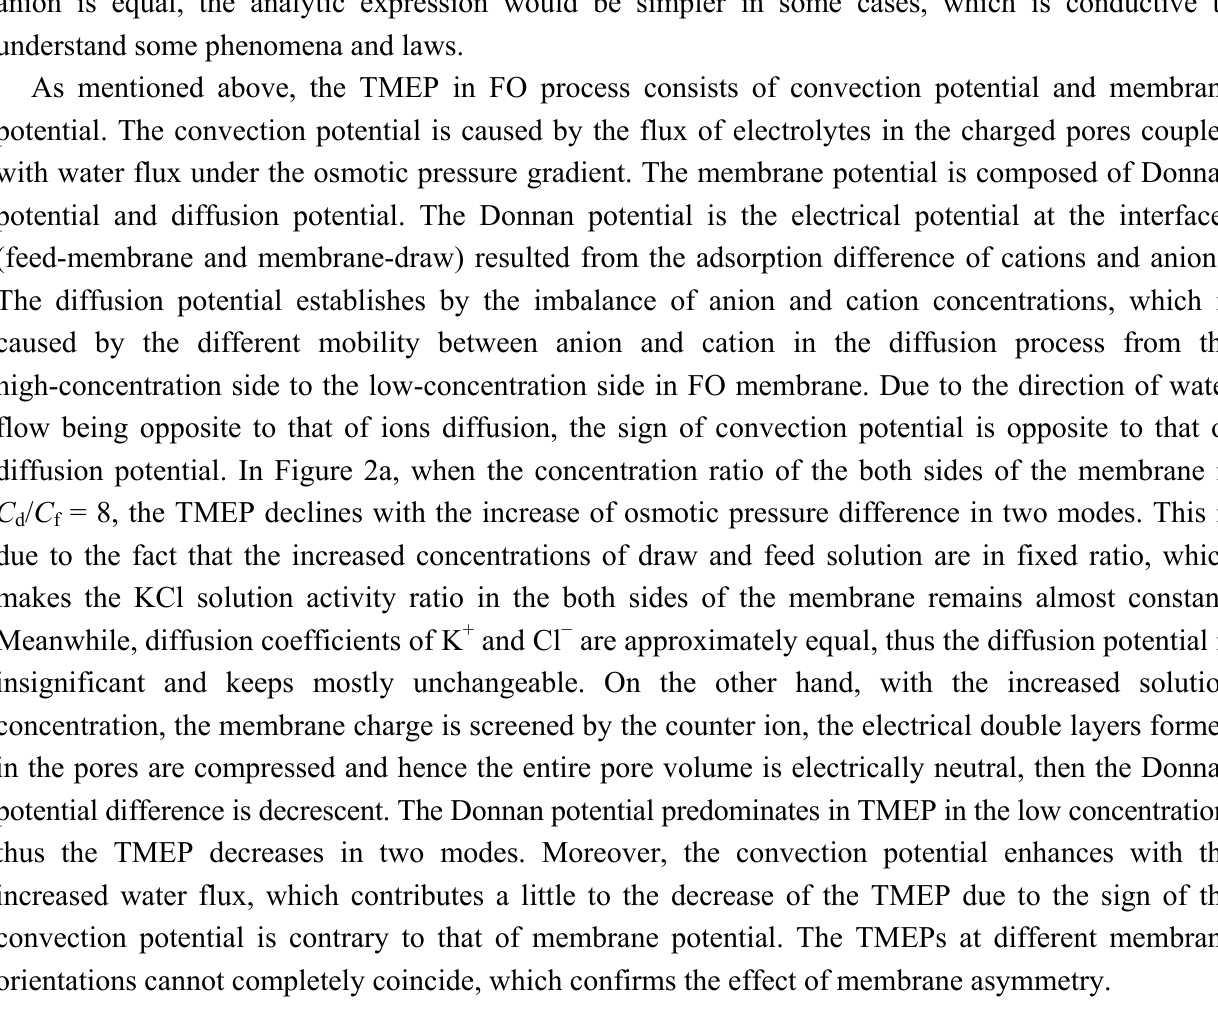
Figure 2. Relationship of transmembrane electrical potential and osmotic pressure difference in two membrane orientations for KCl as draw solute ( t = 25 °C). AL-DS: active layer facing the draw solution; AL-FS: active layer facing the feed solution. ( a ) C ( b ) C = 0.01 M. The osmotic pressure difference refers to the effective values after f correction for the effect of